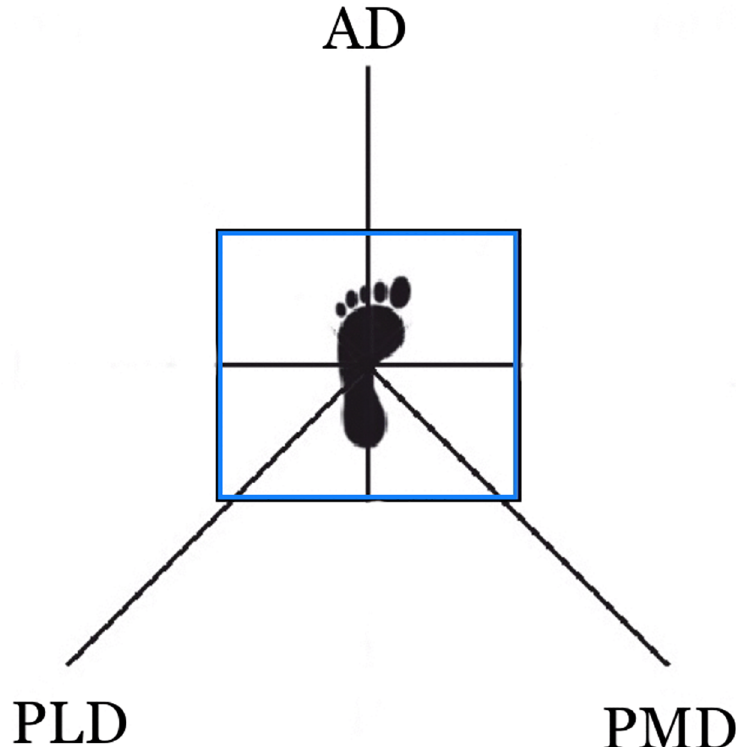
Fig 1. Star Excursion Balance Test for a left test leg. The box represents the force platform. The lines represent the three directions (Anterior, posteromedial, and posterolateral) used in the analysis.